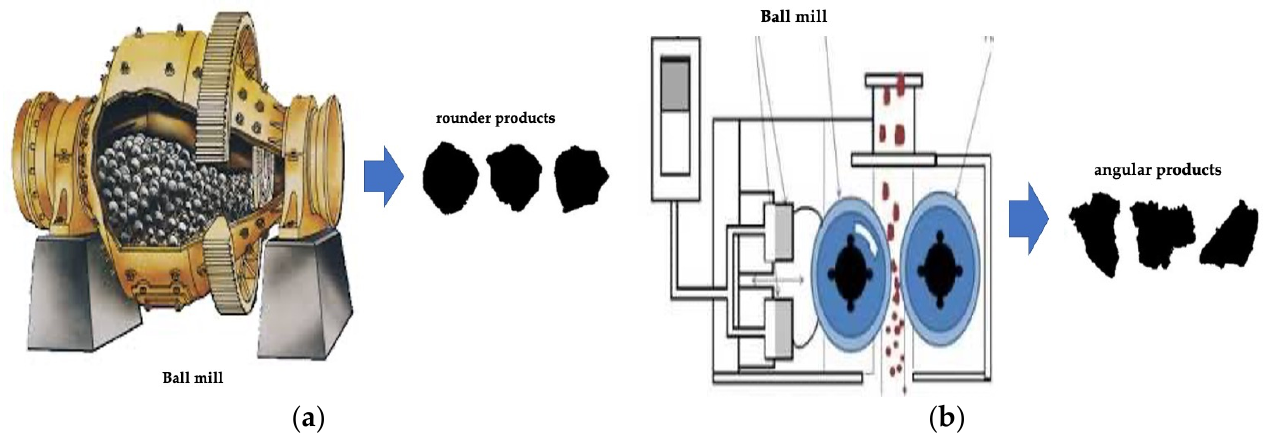
Figure 31. Comparison of particle shape by grinding using a ball mill ( a ) and HPGR ( b ) [586].